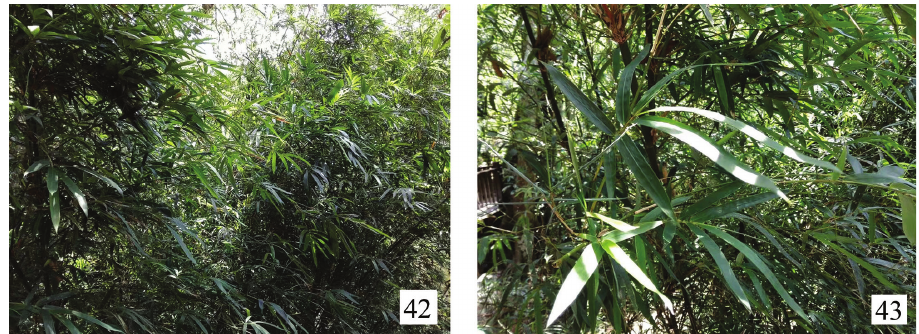
Figures 42–43. Host plant of Bambusiphaga ventroprocessa sp. n. 42 View of the area where the speci- mens of B. ventroprocessa sp. n. were captured, in Lingshui (Hainan, China). 43 View of the plant. Pho- tograph by H.-X.